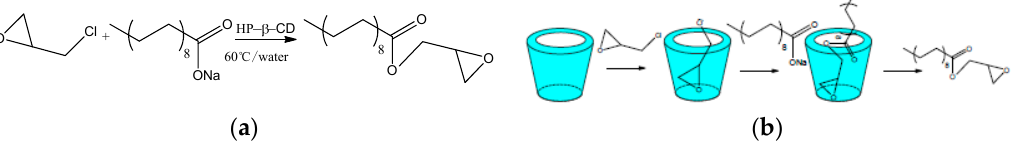
Scheme 15. ( a ) The synthesis of glycidyl monostearate catalyzed by HP- β -CD; ( b ) the proposed mechanism of the synthesis of glycidyl monostearate.